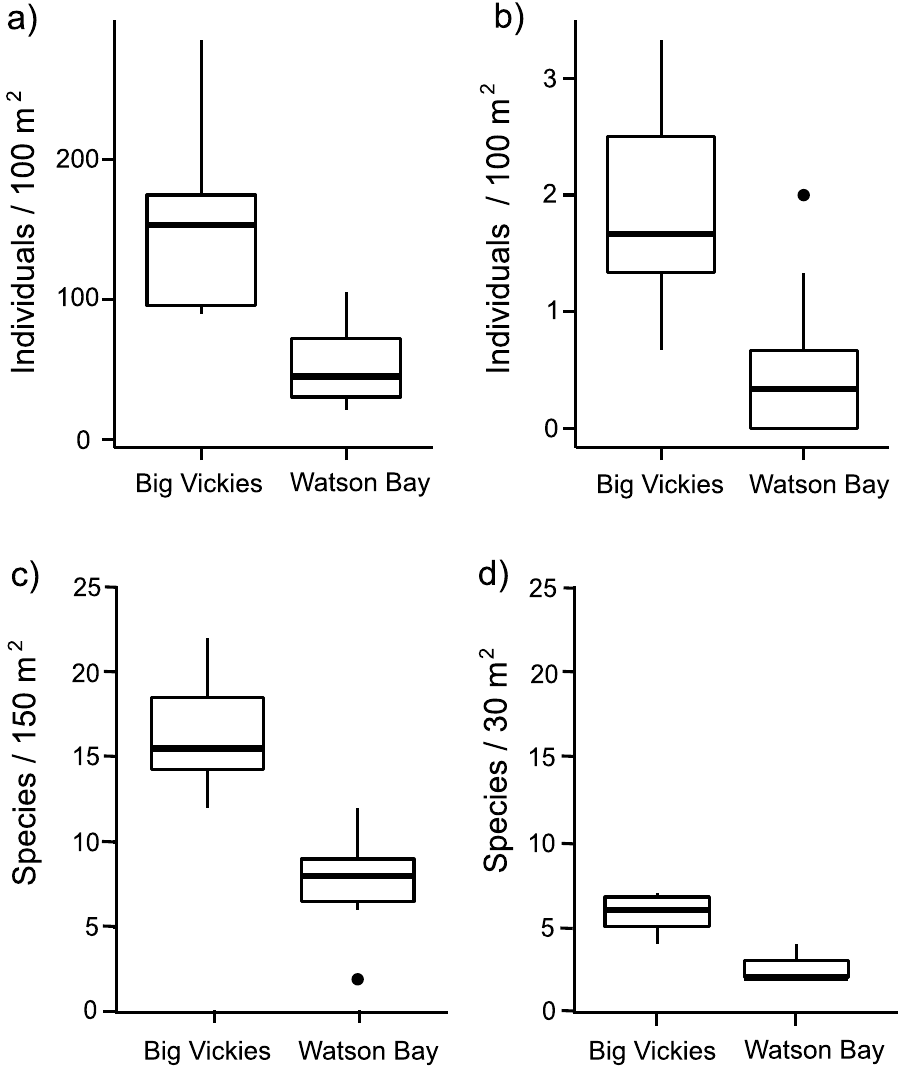
Figure 1. Individual and species counts at the two study sites. ( a ) Boxplots (median and interquartile range) of client fish abundance (number of individuals) and ( b ) cleaner wrasse ( L. dimidiatus ) abundance estimated over 100 m 2 from 10 transects each at Big Vickies (high social complexity) and Watson Bay (low social complexity) sites around Lizard Island. ( c ) Boxplots (median and interquartile range) of large (species > 10 cm TL, estimated over 150 m 2 ) and ( d ) small (species < 10 cm TL, estimated over 30 m 2 ) client species richness (number of species excluding L. dimidiatus ) from same transects as